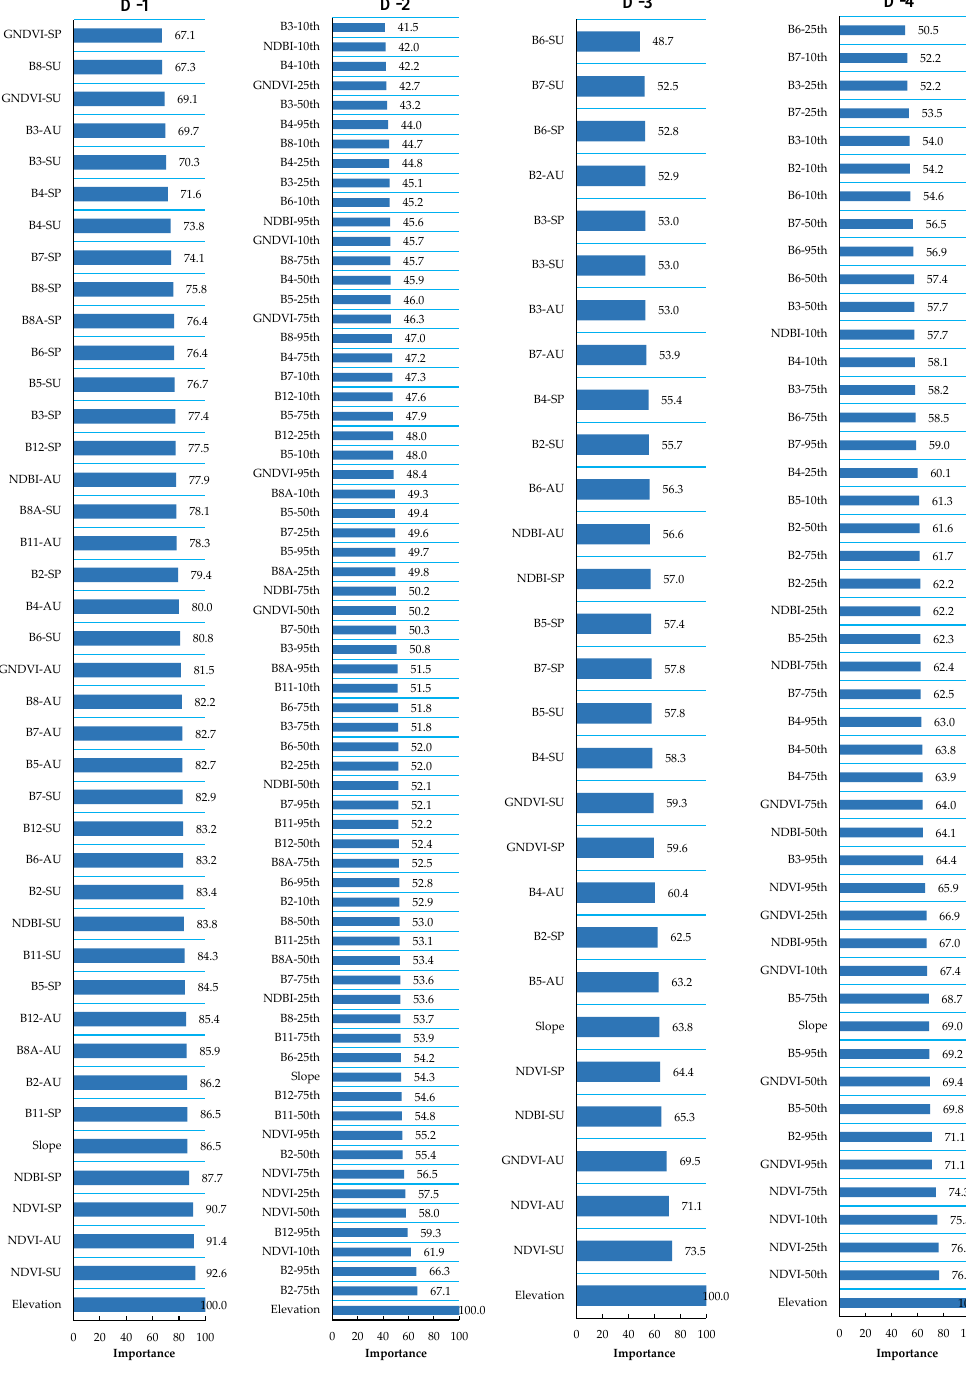
Figure 6. Variable importance scores of all datasets. (D-1) S-2 seasonal composites, (D-2) S-2 percentile metrics, (D-3) L-8 seasonal composites, and (D-4) L-8 percentile metrics.